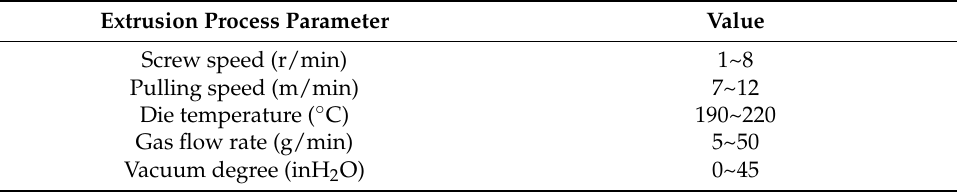
Table 1. The value ranges of extrusion process parameters.